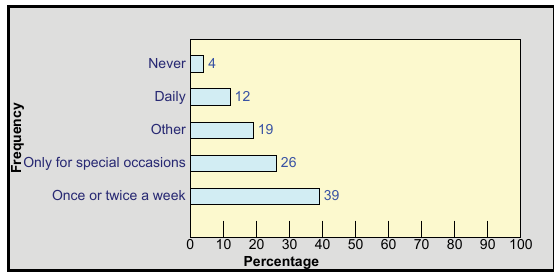
Figure 2. Frequency of use of hearing aids (n=57). Figure 3. Behind-the-ear (BTE) hearing